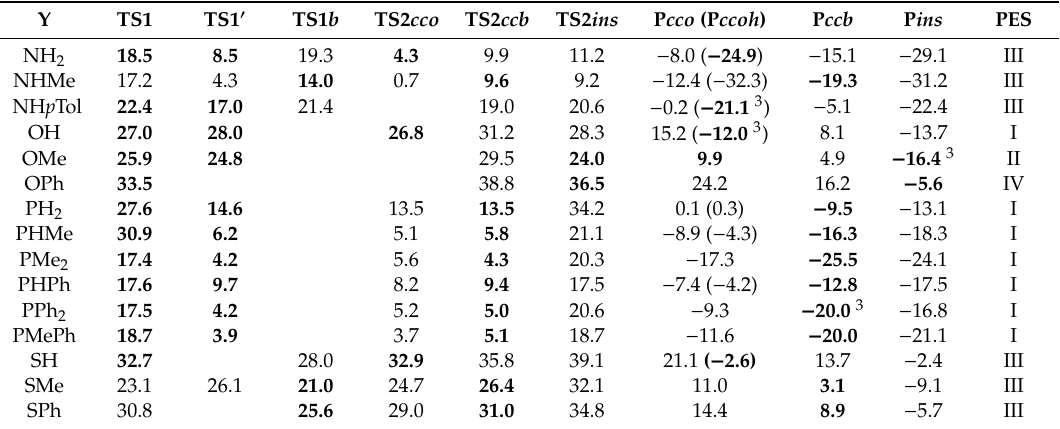
Table 1. Gibbs energy barriers, in kcal / mol, determined by the TS located along the reaction mechanisms found for the reaction between the complexes [ReY(CO) 3 (bipy)] (Y = NH 2 , NHMe, NH p Tol, OH, OMe, OPh, PH 2 , PHMe, PMe 2 , PHPh, PPh 2 , PMePh, SH, SMe, SPh) and HMAD at the DLPNO-CCSD(T) level. 1,2 Gibbs energy, in kcal / mol, of the plausible products referred to that of the respective separate reactants at the same level of theory and type of PES found for each Y ligand are also